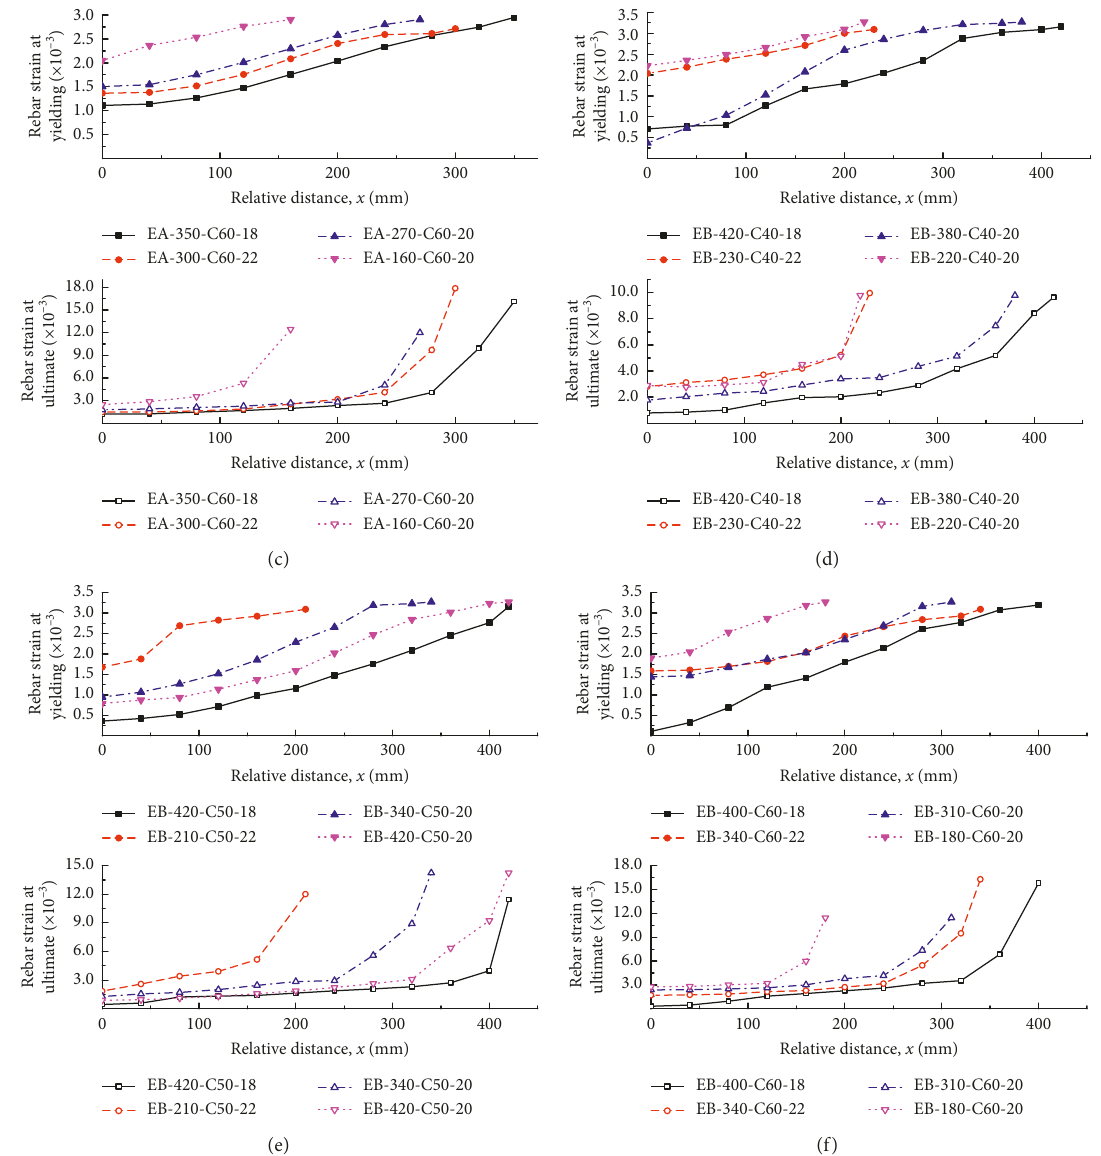
Figure 9: Strain distribution along the tensile reinforcement anchored in the exterior beam-column connection. Specimen type: (a) EA- C40; (b) EA-C50; (c) EA-C60; (d) EB-C40; (e) EB-C50; (f)